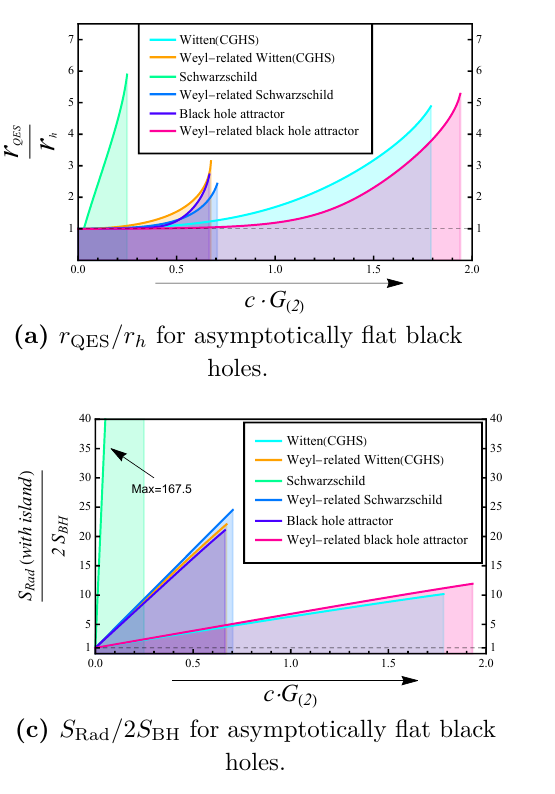
Figure 7. Curves of the QESs and their corresponding late-time radiation entropy with respect to (for asymptotically flat black holes). Diagrams are plotted with setting r c · G (2) = 1 / 8 π r b = 10 r h , G (2)